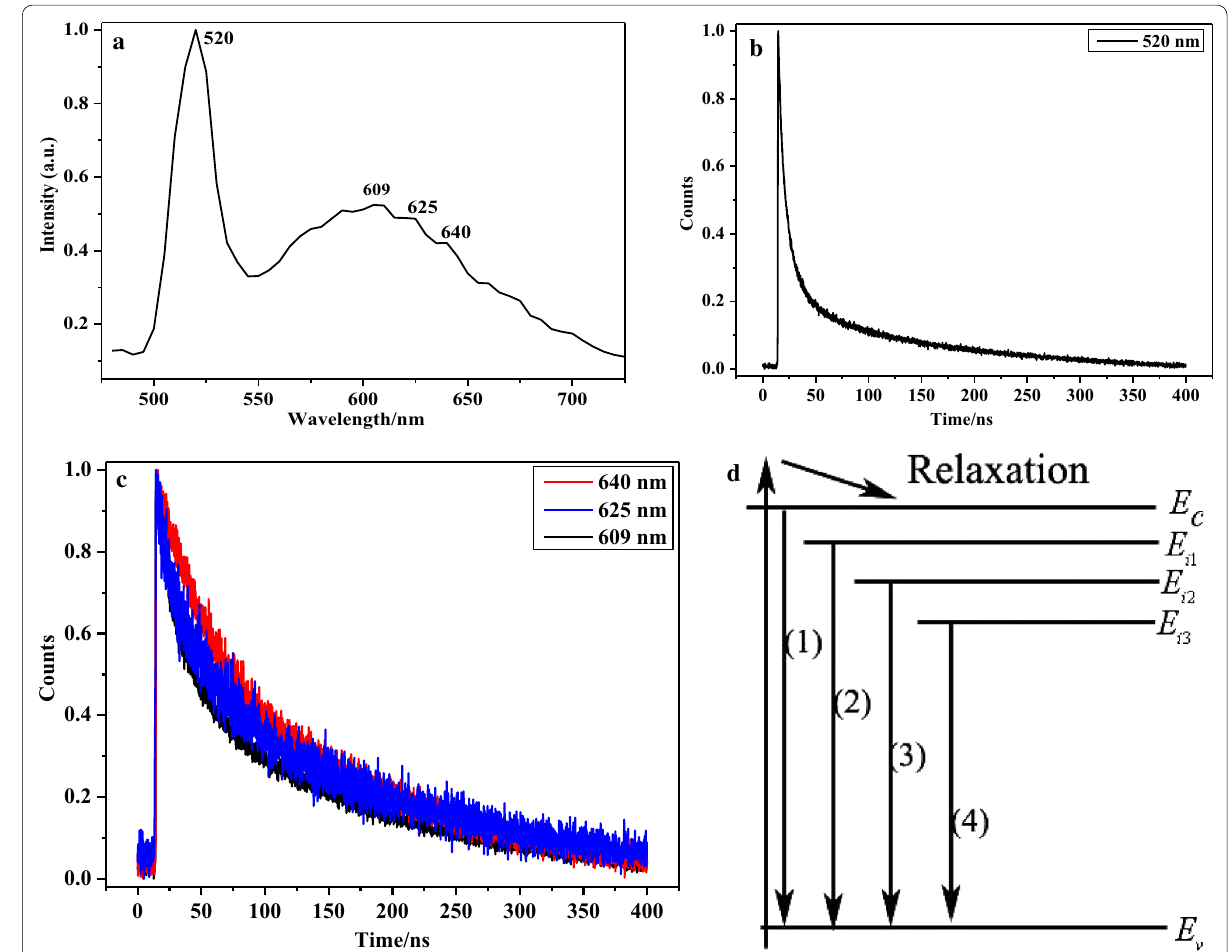
Fig. 7 a PL of Sn–CdS nanowires under excitation of pulse laser with wavelength of 400 nm. b , c The corresponding PL lifetime decay profiles of 520 nm and 609, 625, 640 nm. d The schematic diagram for the carrier with different lifetime decay